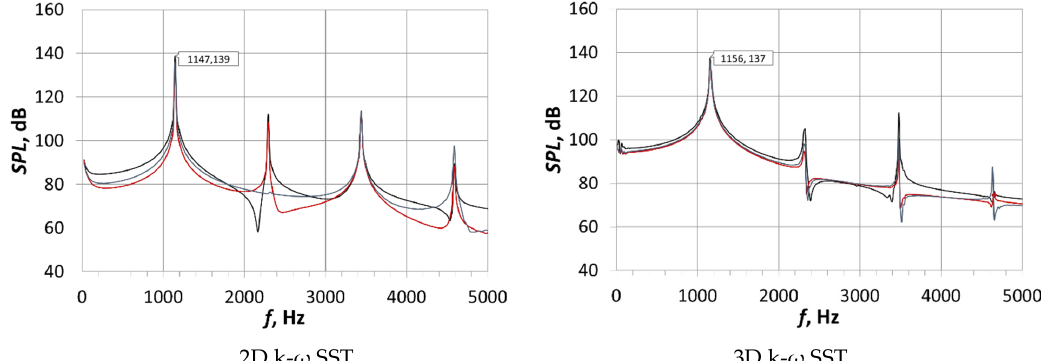
Figure 13. Spectral analysis of SPL for velocity in channel equal to 50 m/s—CFD.